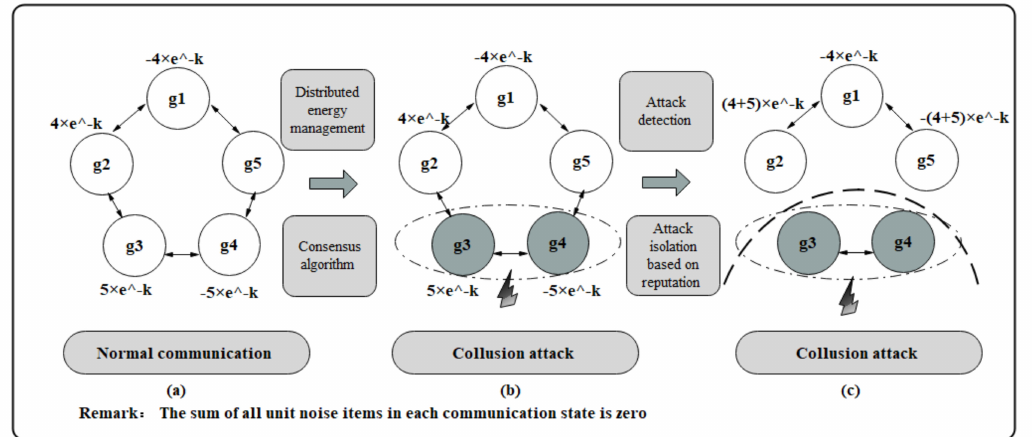
Figure 2. Our proposed privacy protection and isolation method against collusion attacks is used in a consensus-based energy management algorithm. ( a ) Normal communication; ( b ) Communication under collusion attack; ( c ) Communication under privacy protection and isolation